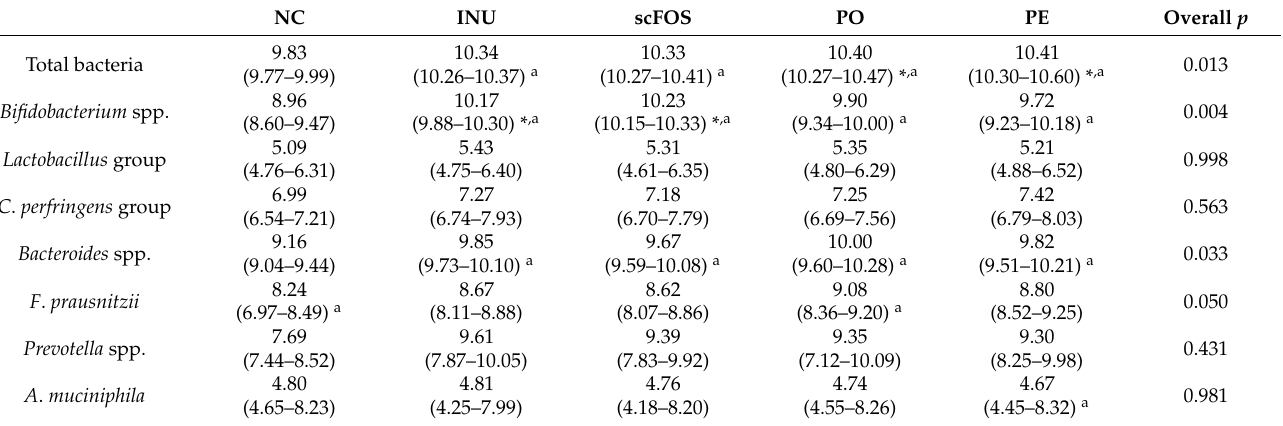
Table 4. Faecal microbial quantification after 24 h of fermentation in neurotypical